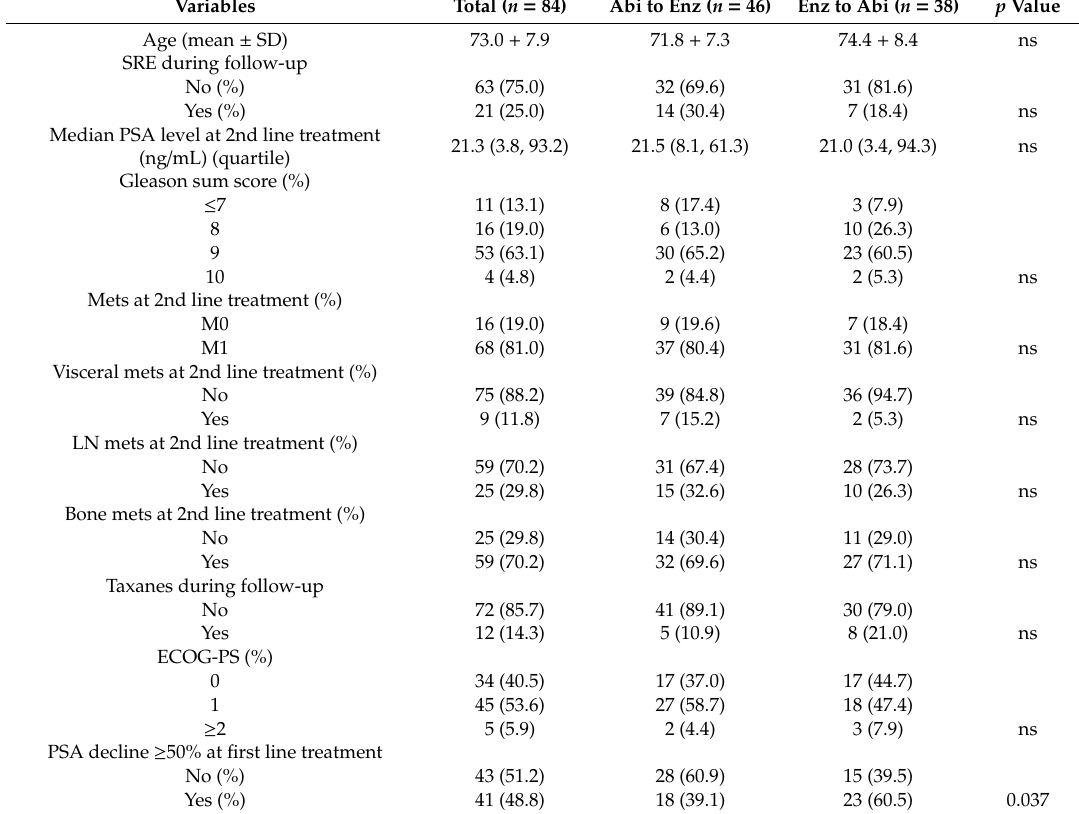
Figure 2. Kaplan–Meier curves for radiographic progression-free survival (rPFS), time to prostate specific antigen (PSA) progression (TTPP), and overall survival (OS) from the initiation of the first-line treatment. Note that there was no significant difference in rPFS, TTPP, and OS between abiraterone and enzalutamide from the first-line treatment. Table 2. Patient characteristics in 84 CRPC patients treated with ASIs as 2nd Table 1. Clinical characteristics in 184 CRPC patients adjusted by propensity score matching.